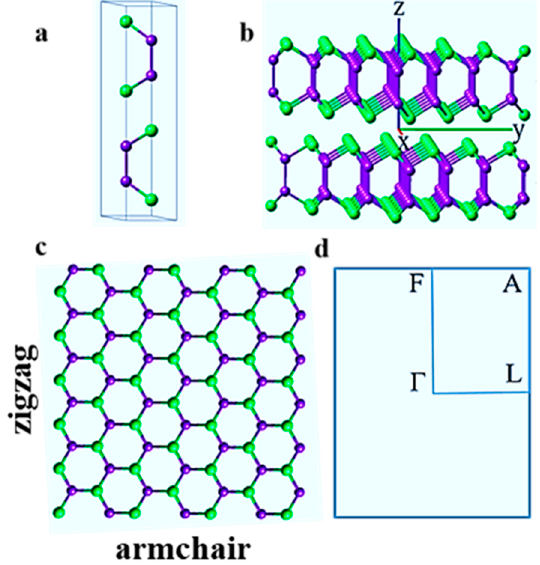
Figure 1. ( a ) Side view of the AB stacking arrangement of atomic structure of a bilayer β -InSe in a unit cell. ( b ) Side view of a bilayer β -InSe. ( c ) Top view of monolayer β -InSe showing armchair and zigzag orientations. ( d ) The 2D-Brillouin zone for monolayer and few-layer β -InSe. The atoms are denoted as In (indigo color) and Se (green color) in the picture.